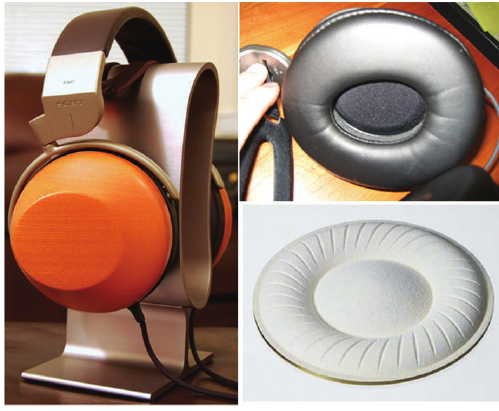
Figure 17: Nanocellulose diaphragm used in SONY